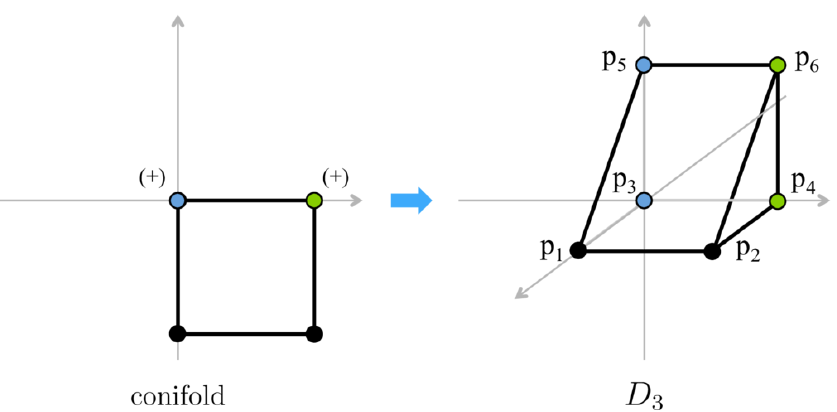
Figure 20. The toric diagram for D 3 , obtained by lifting two perfect matchings of the